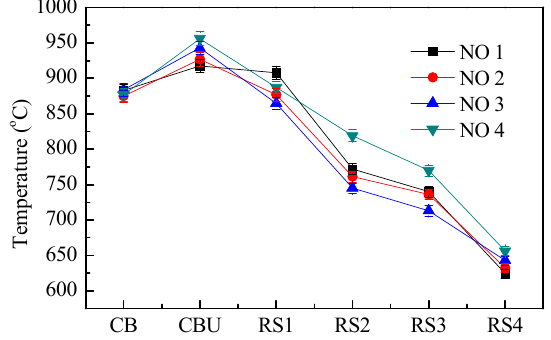
Figure 10. Temperature comparison in the incinerator from bottom to top.